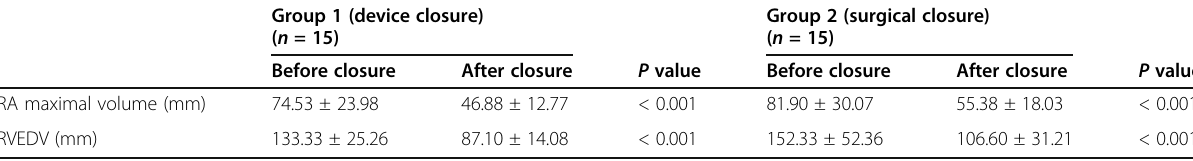
Table 6 Parameters of RA and RV in device and surgical